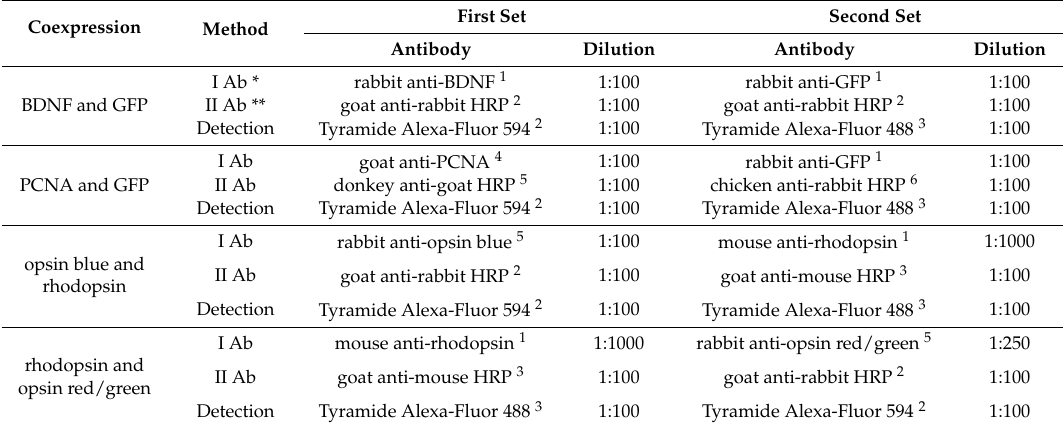
Table 1. List of antibodies employed in double immunofluorescence staining technique. Coexpression